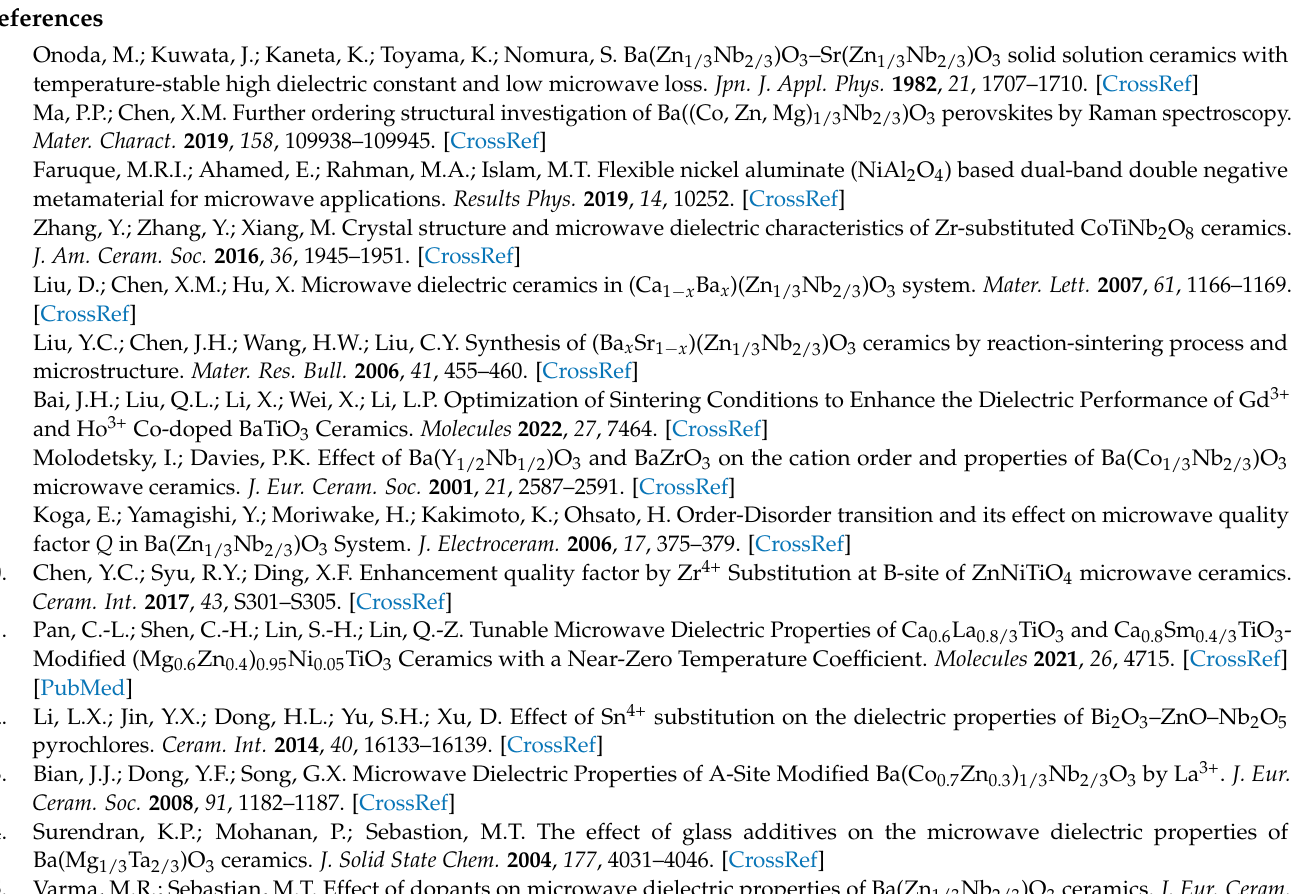
Figure S1: The EDS mapping and corresponding spectrum for the sample with x = 0; Figure S2: The EDS mapping and corresponding spectrum for the sample with x = 0.1; Figure S3: The EDS mapping and corresponding spectrum for the sample with x = 0.2; Figure S4: The EDS mapping and corresponding spectrum for the sample with x = 0.4; Figure S5: The EDS mapping and corresponding spectrum for the sample with x = 0.6; Figure S6: The EDS mapping and corresponding spectrum for the sample with x =